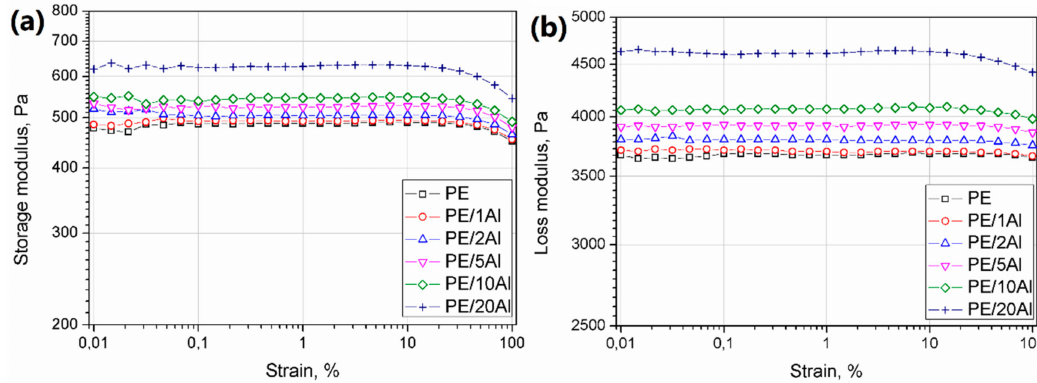
Figure 7. Storage ( a ) and loss ( b ) modulus vs. strain of PE and PE / Al composites.